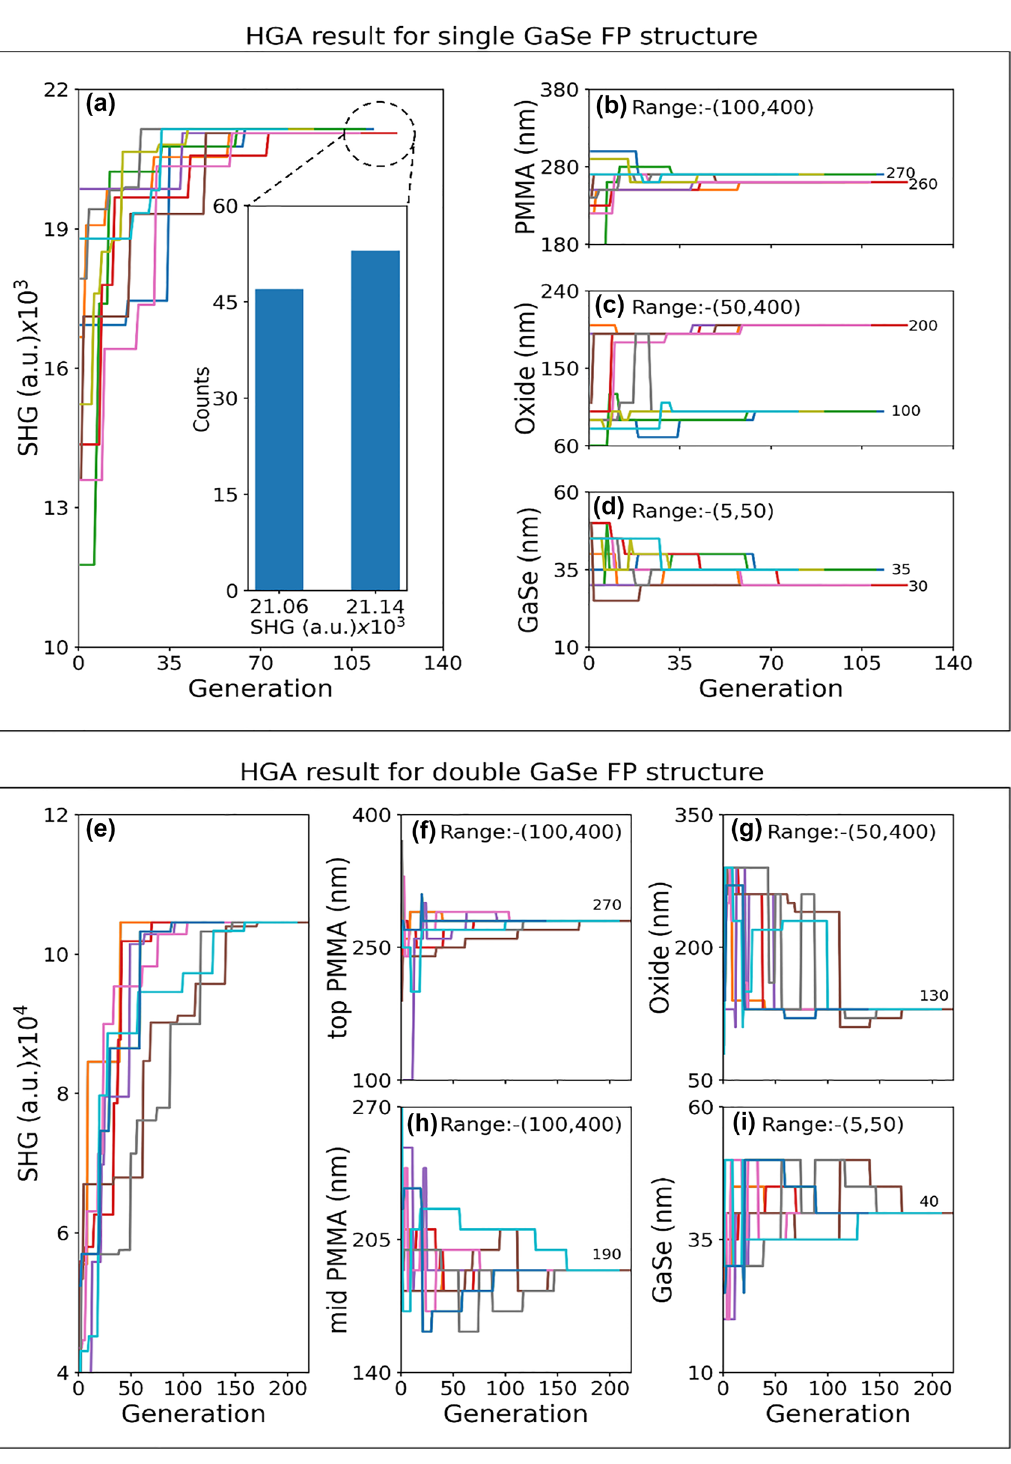
Figure 2: Summary of the HGA optimization results. (a) SHG signal for single GaSe FP structure, and optimized thickness values for: (b) PMMA layer, (c) SiO layer and (d) multilayer GaSe as a function of iteration number of the HGA optimization process. The results of HGA are shown for ten 2 independent runs. Histogram showing the SHG signal for the optimized structure for 100 independent simulation runs is shown in the inset of (a). (e) SHG signal for double GaSe FP structure and thickness of: (f) top PMMA layer, (g) SiO function of iteration number of the HGA optimization process. The results of HGA are shown for ten independent runs. The thickness range and optimum values obtained are specified in (b–d) and